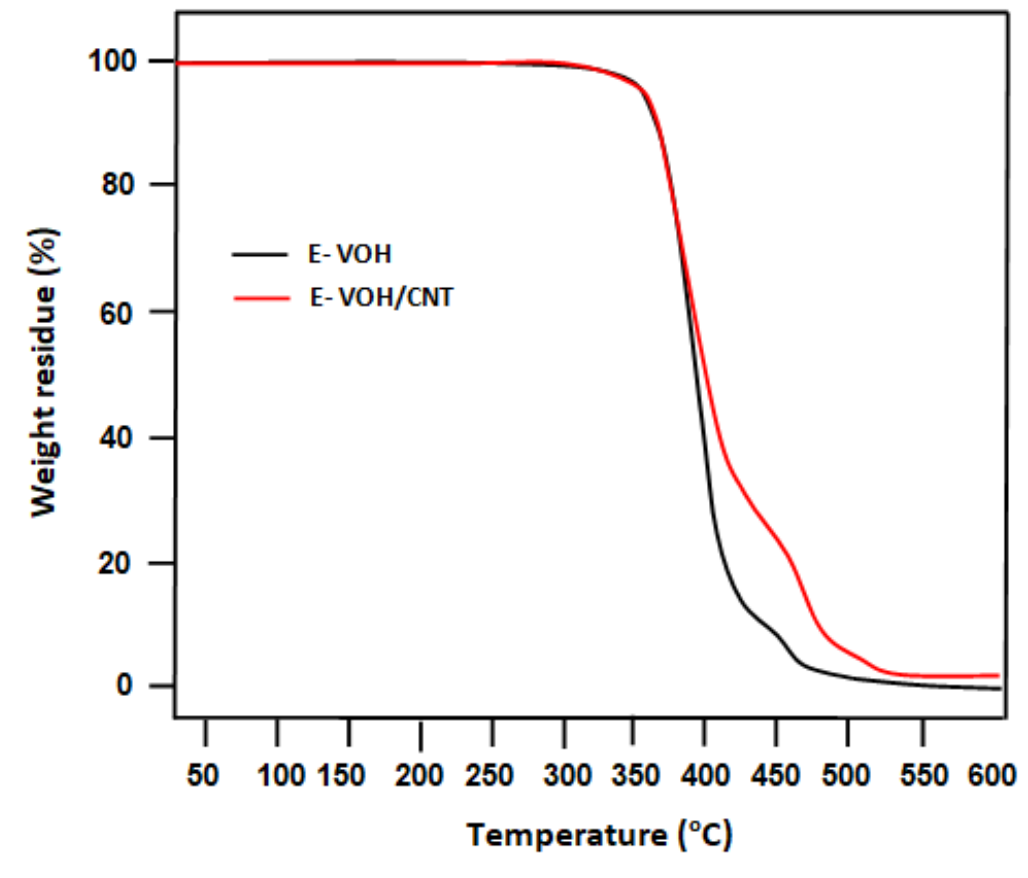
Figure 3. Thermogravimetry analysis (TGA) thermograms of E-VOH and E-VOH/CNT nanocomposite.